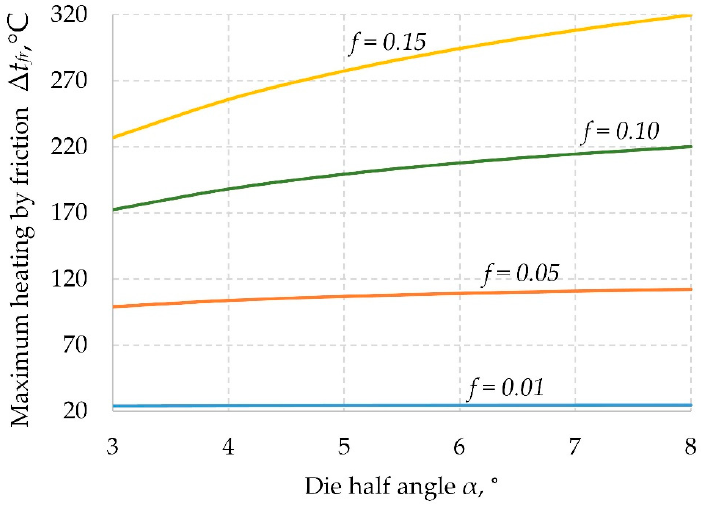
Figure 3. Maximum heating of the steel wire due to contact friction in the die. The thickness of the surface layer of the metal heated by friction along the drawing route ( f = 0.15) is given in Table 2. Table 2. Heating of the steel wire surface by friction during drawing. Drawing Route